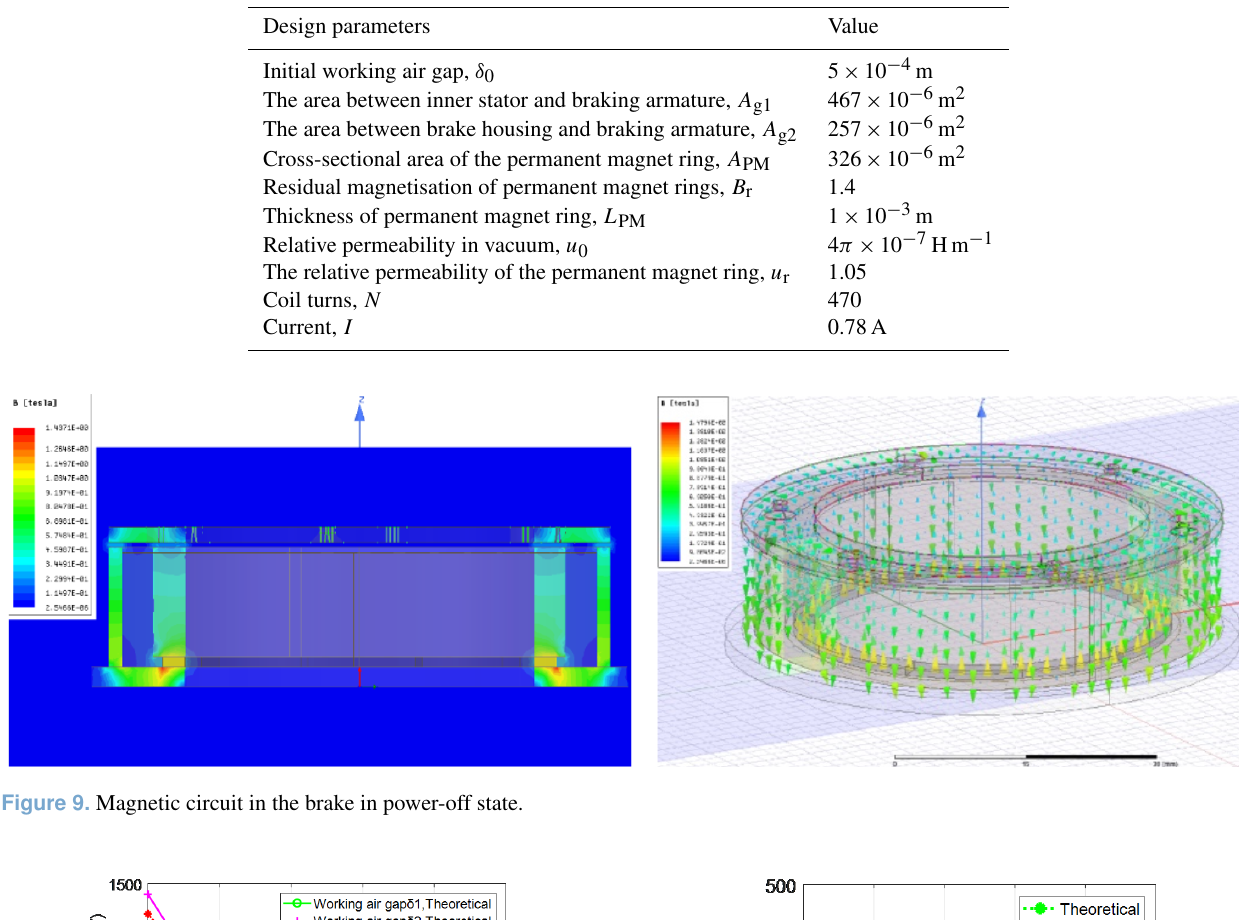
Table 2. Electromagnetic design parameters of the brake.